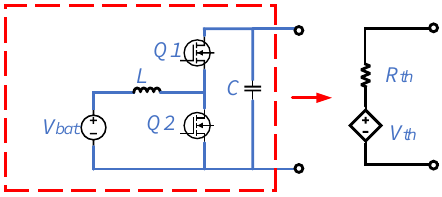
Figure 3. The equivalent circuit for battery